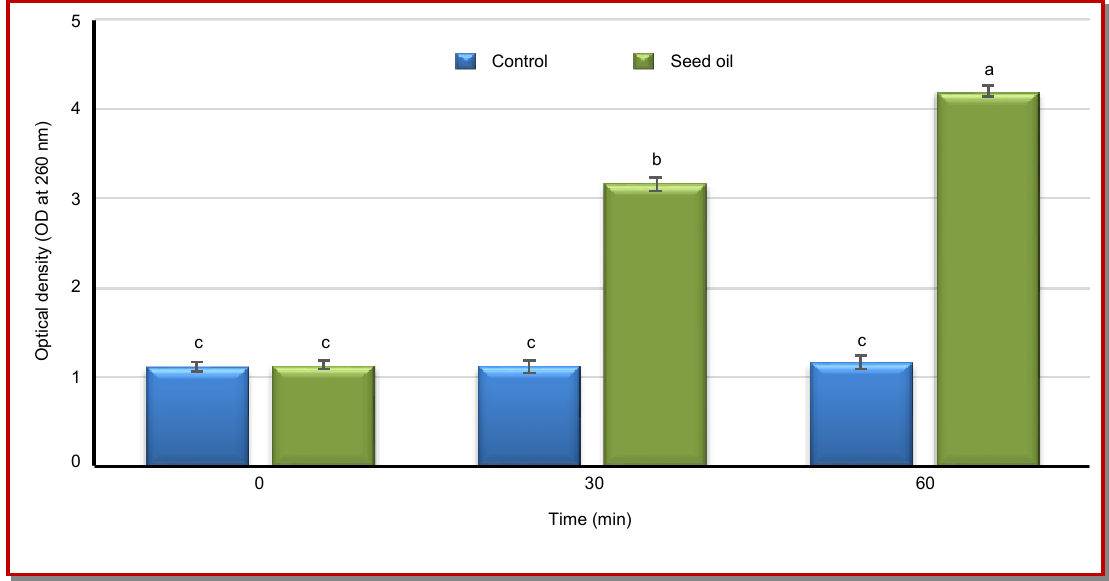
Figure 2: Effect of the Caesalpinia bonducella seed oil (CBSO) on the release rate of 260-nm absorbing material from L. monocytogenes NCIM 24563 (a) and E. coli ATCC 25922 (b). Data are expressed as mean ± SD (n = 3). Values with different superscript (a, b, c) are significantly different ( p<0.05 ) between control and treatment